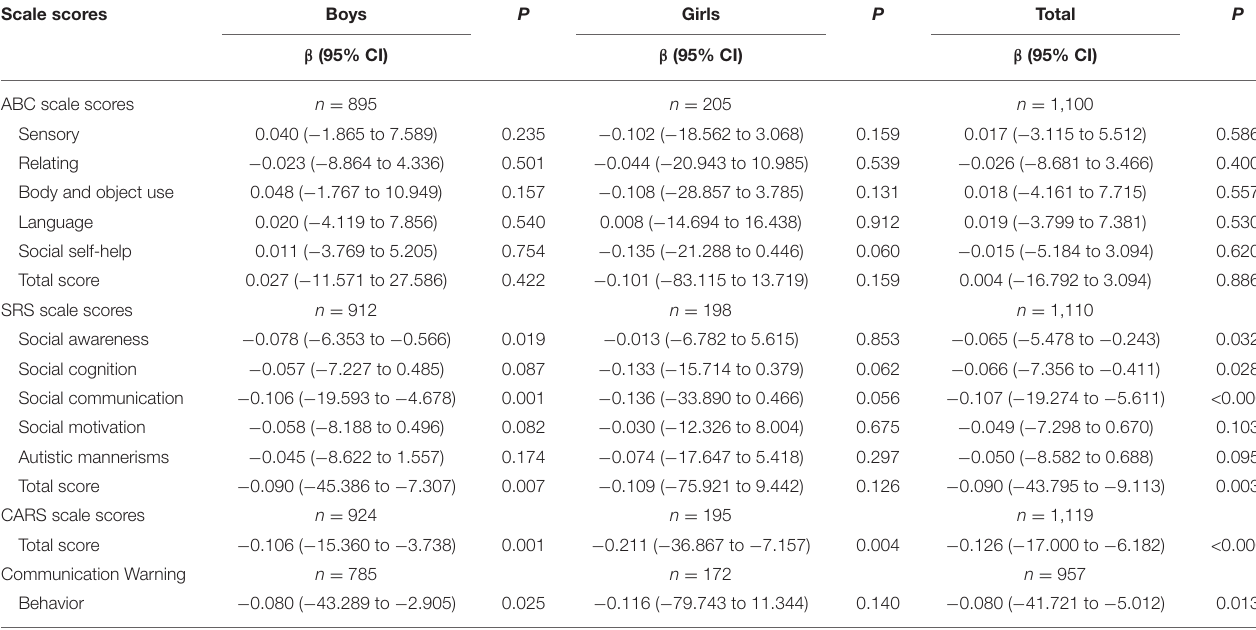
TABLE 4 | Effect of serum VA level on the scores of ABC, SRS, CARS and communication warming behavior of CBNS-R2016 in the ASD children at different gender groups. Scale